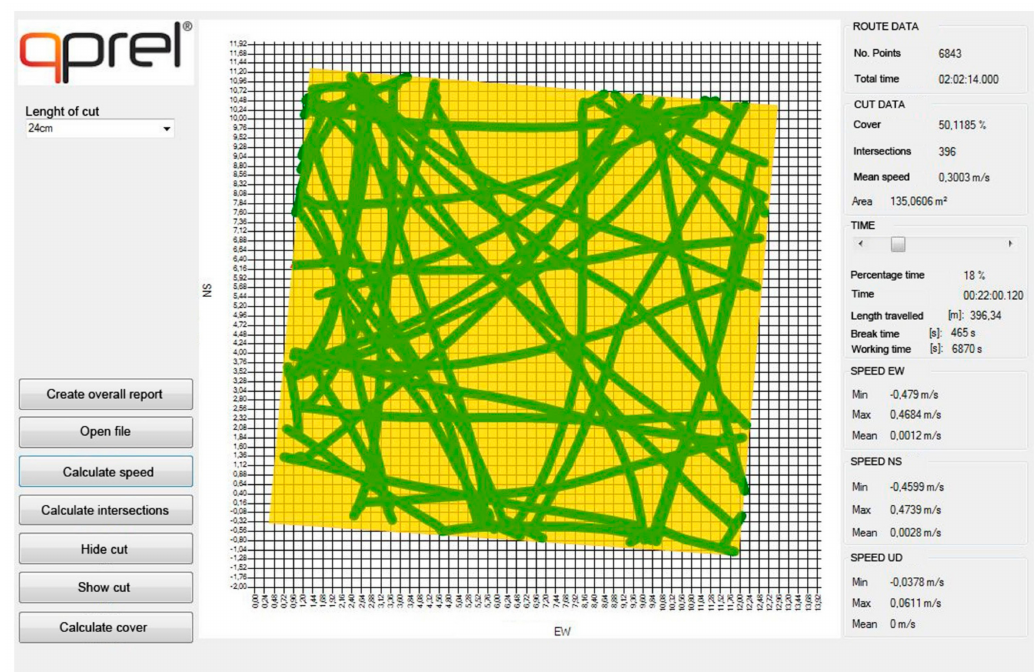
Figure 4. Window of the “Robot mower tracking data calculator” software showing the 50% of turfgrass cut area by the robot mower after 22 min of work (green lines). The yellow area is the area corresponding to 135 m 2 . The mean speed in the CUT DATA panel is the ratio between the distance travelled and time elapsed. The SPEED NS EW and UD are the north to south, east to west, and up to down speeds, considered as vectors with their magnitude and direction. The zero point of the axis is the base station